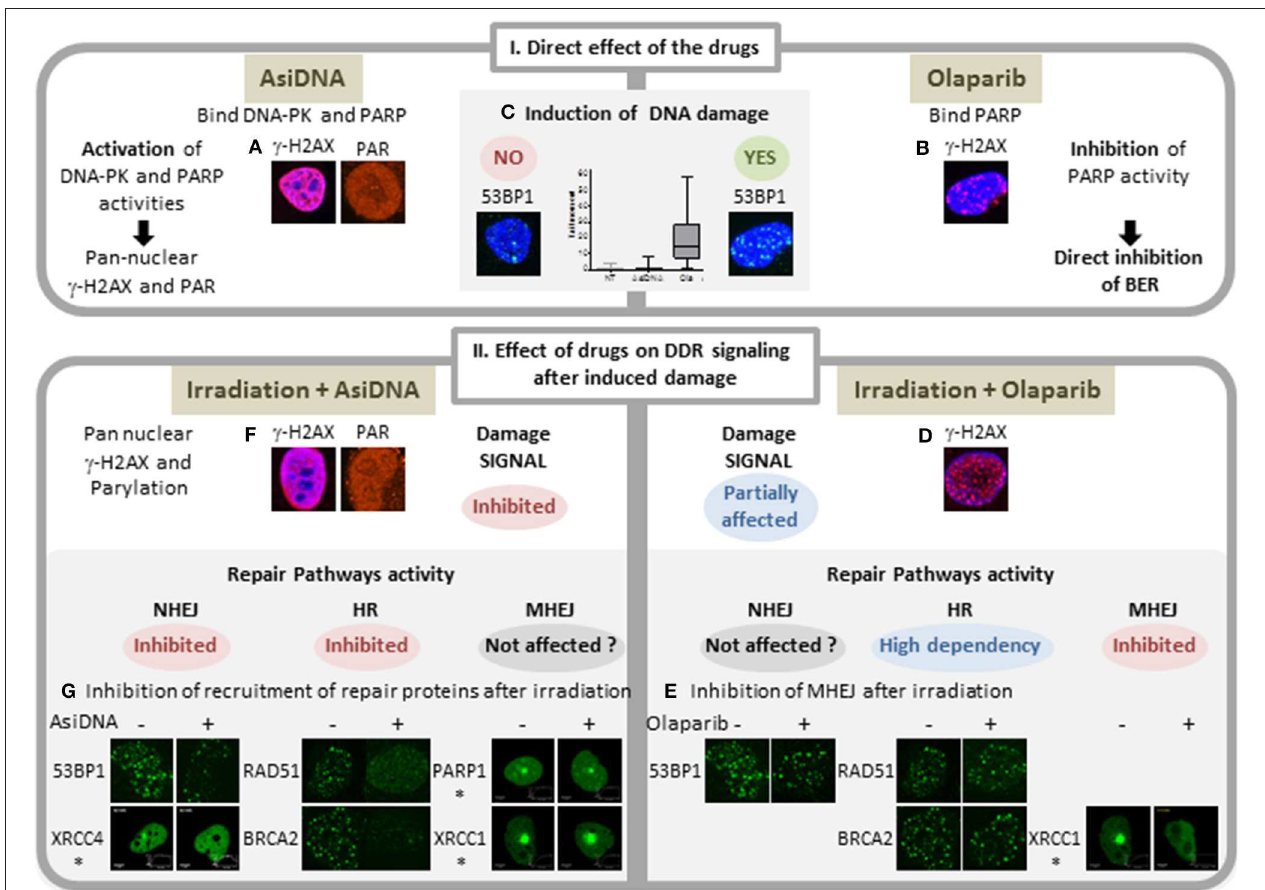
FIGURE 1 | Comparison of main features of AsiDNA and Olaparib activity on DNA repair. I: Activity of the inhibitors AsiDNA (left) and olaparib (right). AsiDNA is a short modified DNA mimicking double-strand break. It binds DNA-PK and PARP enzymes and activates their kinase and polymerase activity leading to modification of a large number of cellular proteins including pan nuclear γ -H2AX protein and poly-ADP-Ribose (PAR) (A) . These modifications occur in absence of DNA damage as revealed by 53BP1 foci and comet assay (C) (12). In contrast, olaparib inhibits PARP polymerase activity and induces increase of DNA damage (13) (B,C) probably through inhibition of base excision repair (BER) and increase of replicative stress. II: Drug effect on damage signaling and recruitment of DSB repair proteins after damage. Damages were induced either by γ irradiation or laser (*). Three DSB repair pathways were monitored: homologous recombination (HR), non-homologous end joining (NHEJ), and micro homology end joining (MHEJ, also called alt-NHEJ). Whereas, olaparib inhibits the formation of foci of XRCC1 and PARP1 (14), it has no effect on formation of radio-induced foci of γ -H2AX, 53BP1, RAD51, and BRCA2 (D,E) . In contrast, AsiDNA inhibit recruitment of 53BP1, XRCC4, RAD51, and BRCA2 ( 15) (F) and do not prevent recruitment of PARP and XRCCI (G)